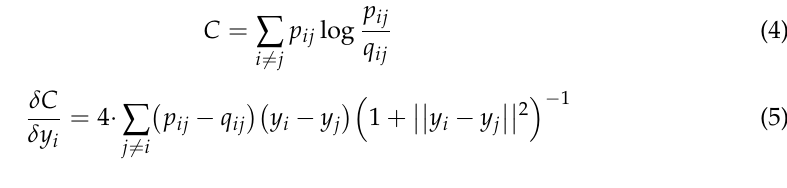
Figure 3. BLSTM flowchart. 3. Method The signals generated by the production machines in the wafer grinding process output many data sets. People can use data visualization and correlation analysis to find the trend of data distribution and the dependence between different wafer grinding parameters. Then, we adopt the importance analysis, one of the machine learning techniques, to search the key grinding parameters, and monitor them to figure out the pattern of parameter changes before and after wafer chipping. Tuning the parameters in time might appropriately avoid wafer chipping and increase the yield of wafer grinding.